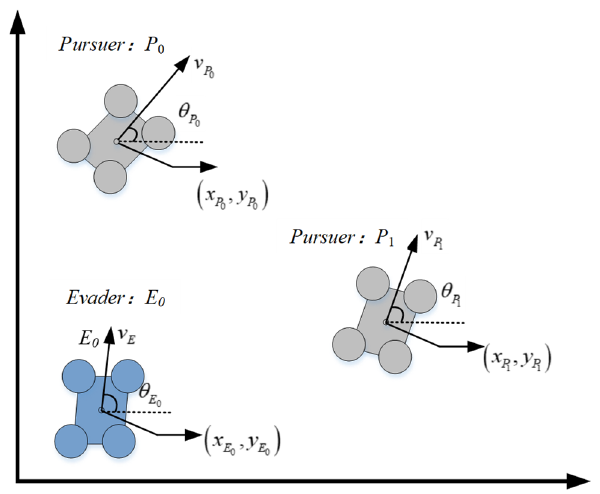
Figure 1. The initial condition of the two pursuers and the evader.